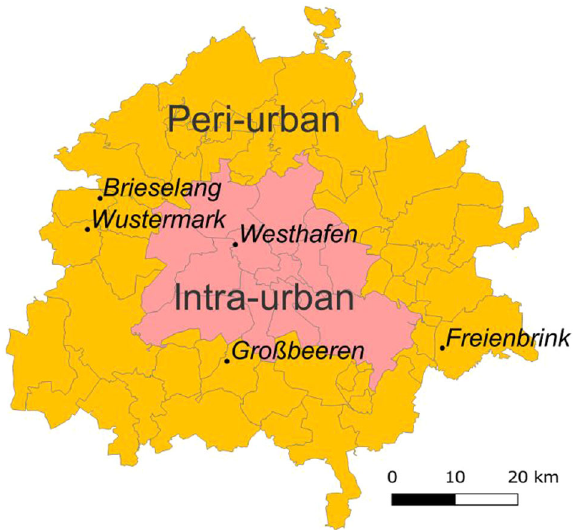
Fig. 4 Berlin ’ s city region. Intra- and peri-urban spaces of the Berlin city region with district borders (grey) and freight distribution centres (italic); CC-BY 4.0 Gösta F.M. Baganz/dl-de/by-2-0 GeoBasis- DE/LGB [WFS BB-BE VG].